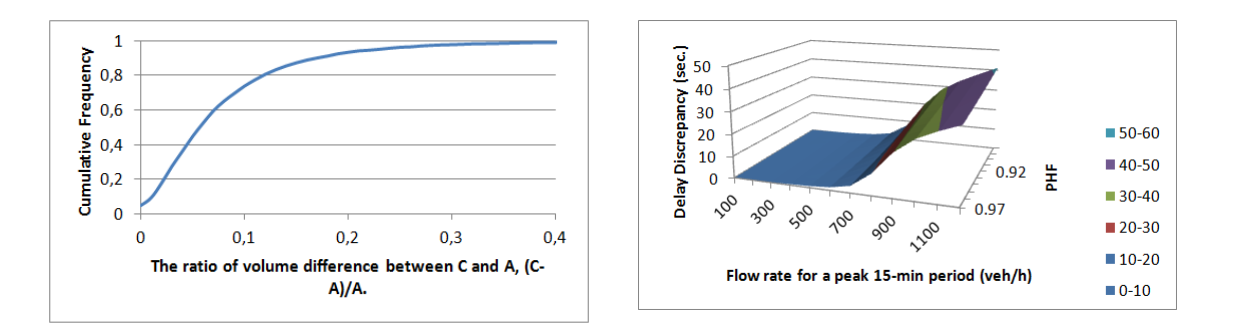
Figure 7. Cumulative Frequency of the Ratio of Volume Difference between C and A